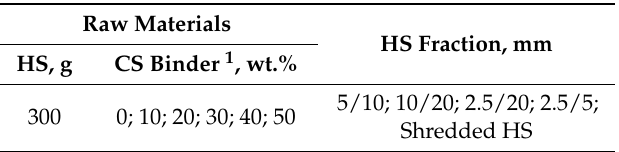
Table 1. The compositions of biocomposite